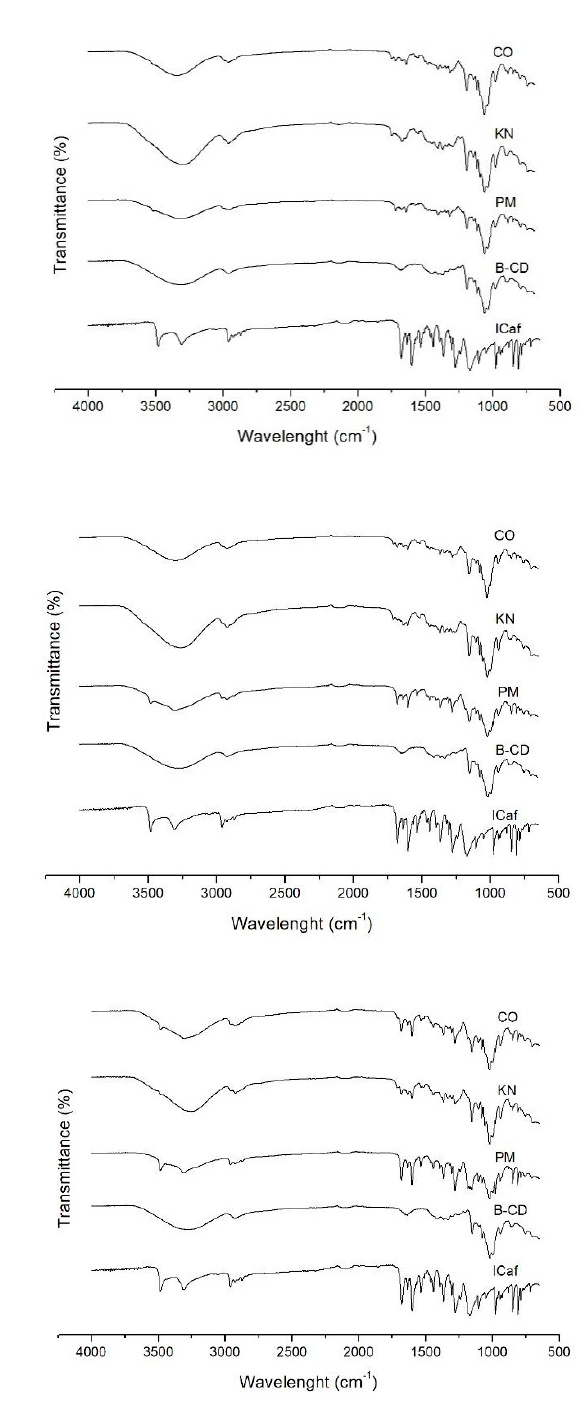
Figure 4. Fourier transform infrared spectroscopy spectra of isopentyl caffeate (ICaf), β -cyclodextrin ( β -CD), and inclusion complex prepared by physical mixture (PM), kneading (KN) and co-evaporation (CO) using molar ratios of (ICaf: β -CD) of ( A ) 0.25:1, ( B ) 1:1 and ( C ) 2:1. SEM is a technique widely used to qualitatively define the formation of inclusion complexes.